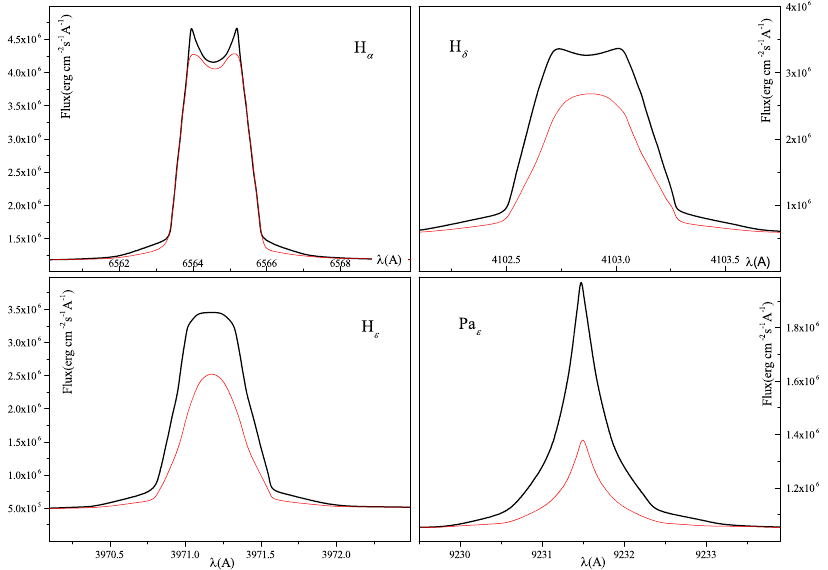
Figure 13. Line profiles with (full) and without (red tiny) inclusion of chemi-ionization and chemi-recombination processes for H